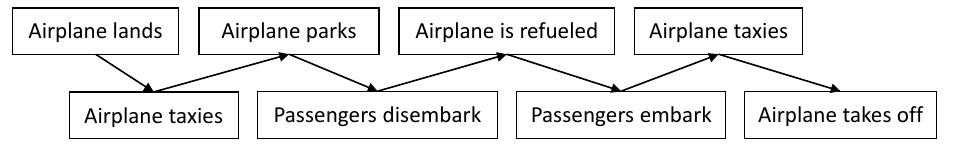
Figure 1. A simplified illustration of a discrete event model, showing possible events taking place at an airport between the arrival and departure of an